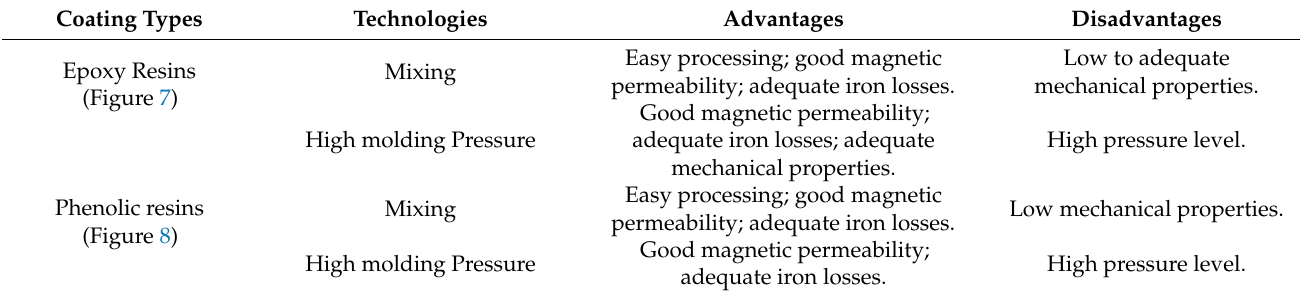
Table 2. Advantages and disadvantages in the adoption of various organic